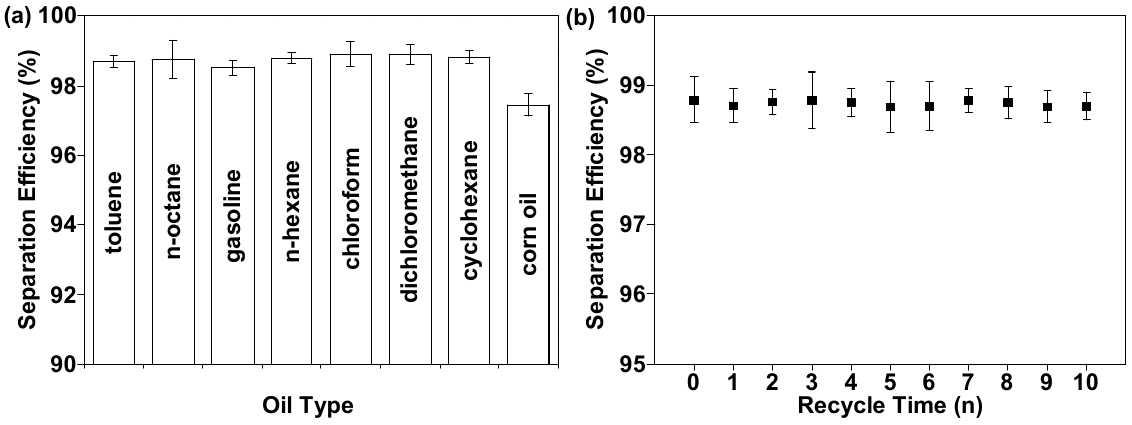
Figure 7. ( a – f ) Oil–water separation process of OTS@Fe 2 O 3 -NCs@SSM (water dyed with methyl blue and dichloromethane dyed with Oil red O).